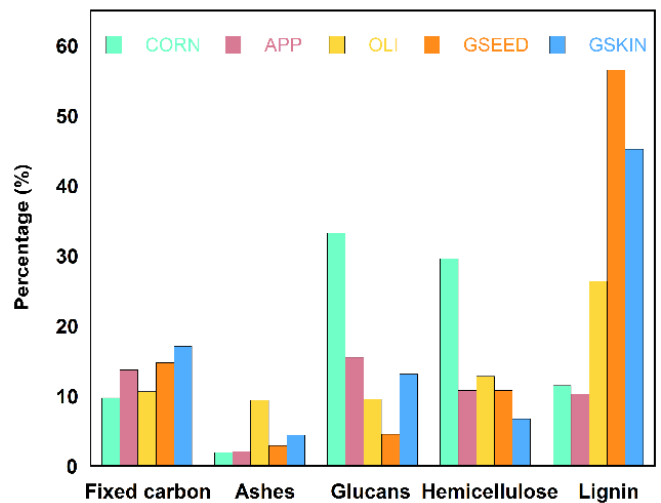
Figure 1. Fixed carbon, ashes, glucans, hemicellulose and lignin analysis comparison of the biowaste samples.